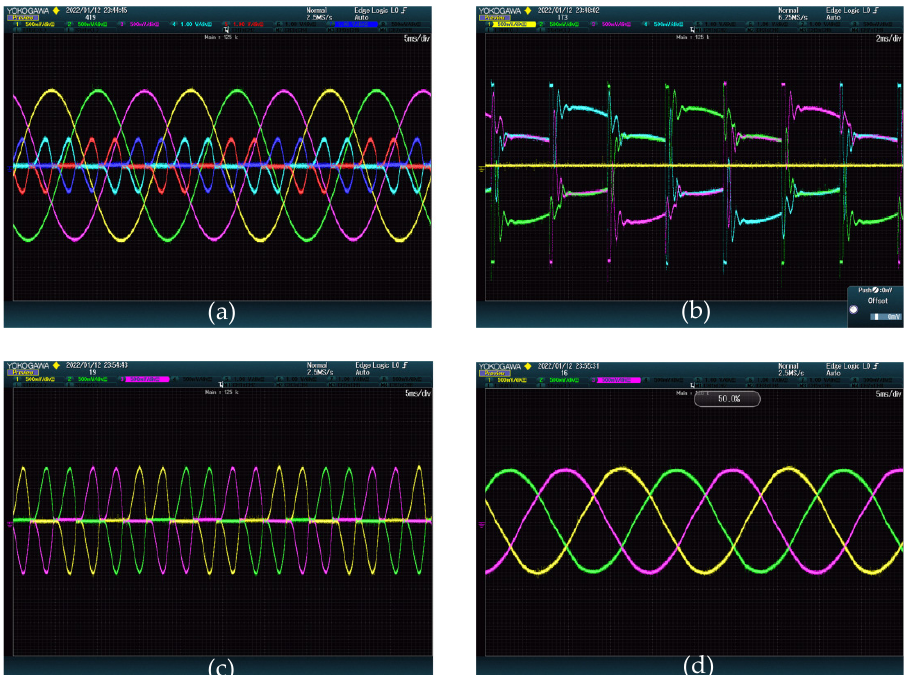
Figure 14. Oscilloscope image of the results of case study 1/scenario A. From left to right, top to bottom: ( a ) diesel generator phase voltages and currents; ( b ) battery currents (at the battery itself and at the output of the filter); ( c ) input currents to the propulsion system; ( d ) stator currents of the induction motor.